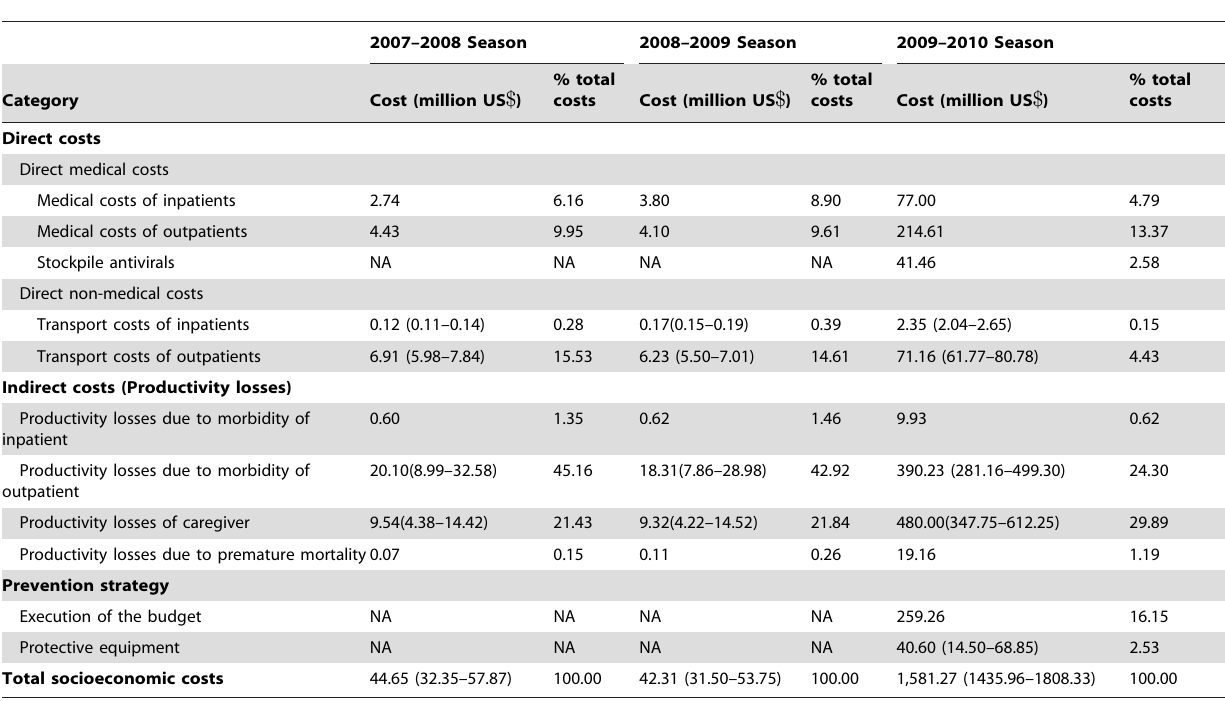
Table 3. Estimating Costs of Illness for Pandemic Influenza A (H1N1) 2009 and Seasonal Influenza in the Republic of Korea, 2007–